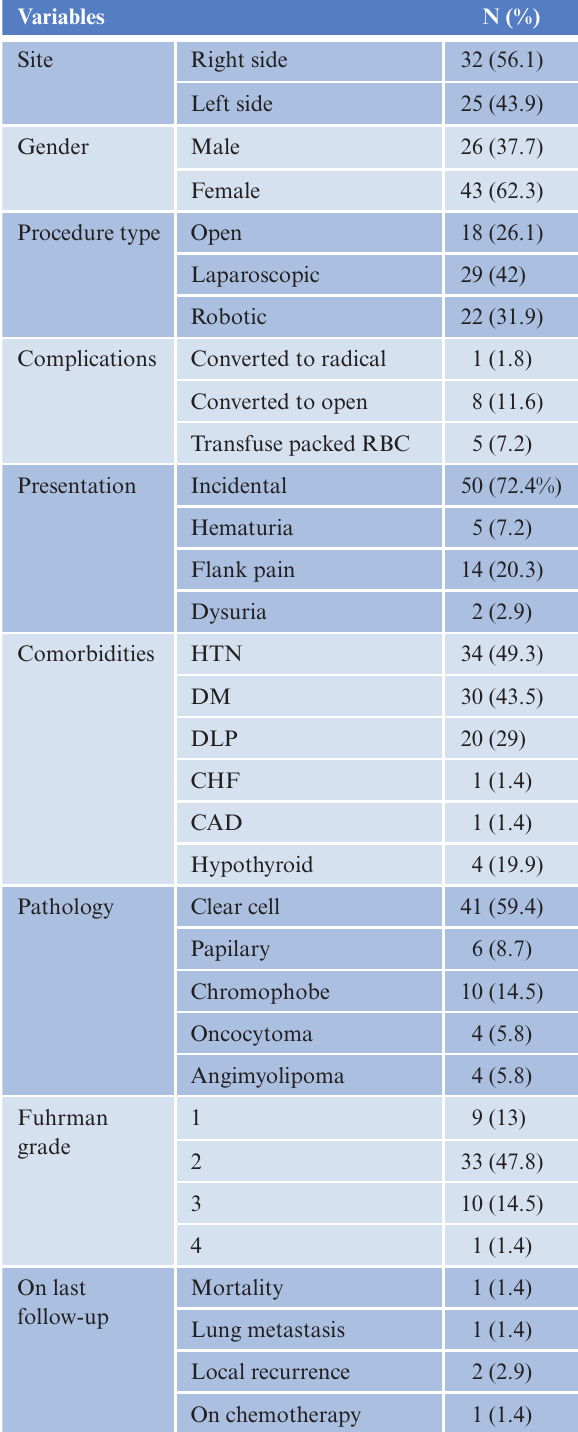
Table 1: Baseline characteristics of patients. Table 2: Baseline mean values of